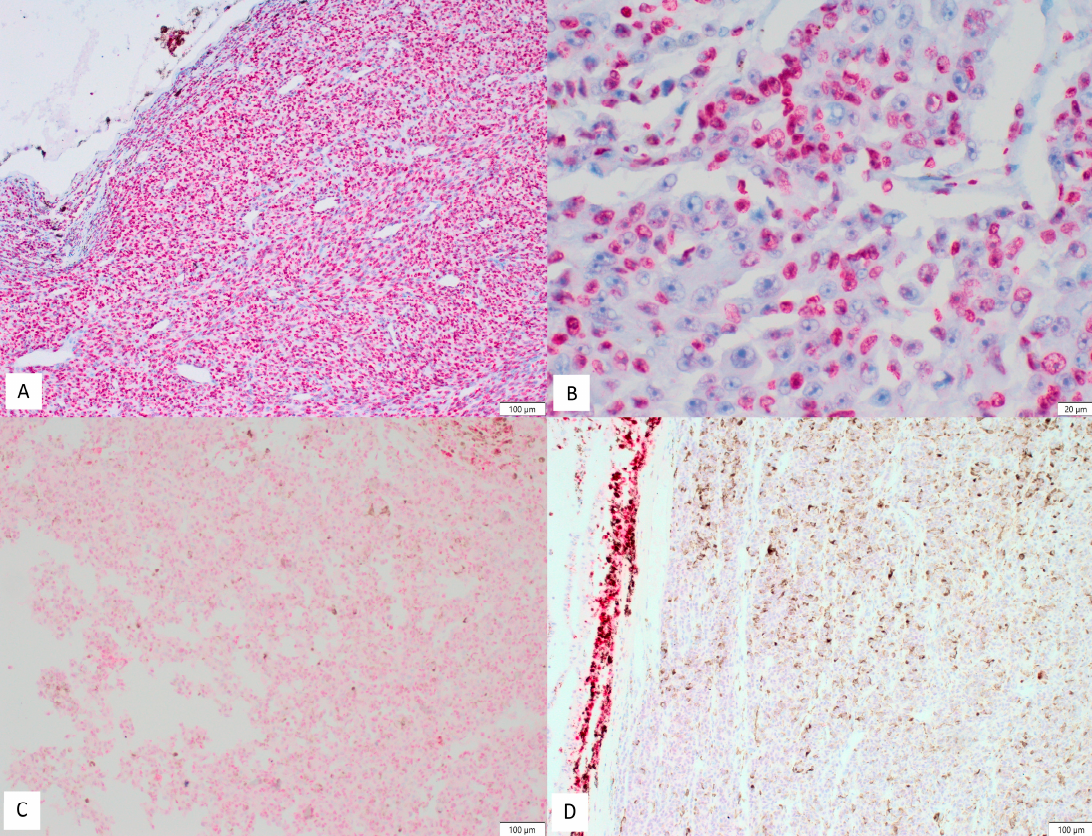
Figure 1. Examples of PARP-1 staining in uveal melanoma cells: ( A ) example of high expression (100×); ( B ) example of high expression—intense nuclear staining visible only in about half of tumoral cells (400×); ( C ) example of low expression (100×); and ( D ) complete lack of staining in tumoral cells. Focally positive internal control (100×).